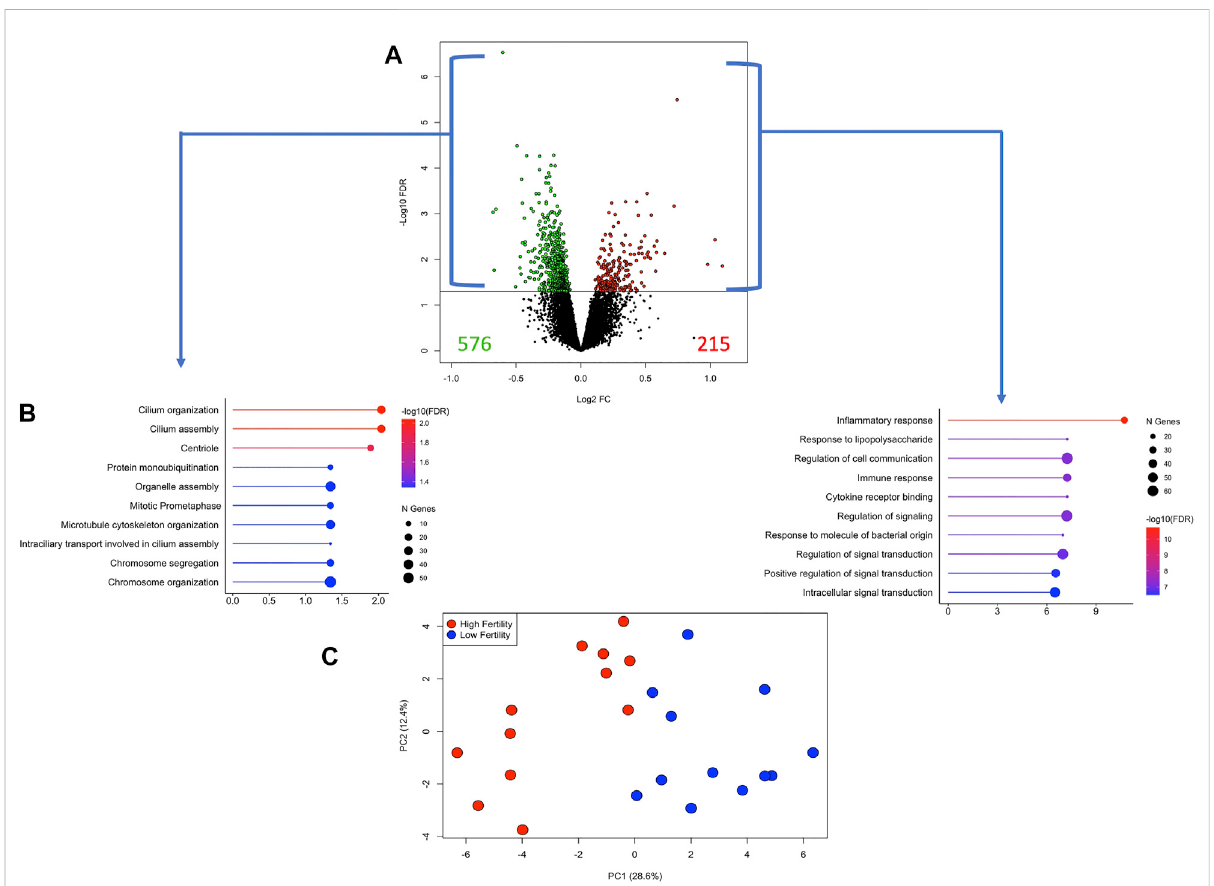
FIGURE 5 Differentially expressedgenes (DEG) in endometrial explants exposed to a Day 15 conceptus from a high fertility (HF) or low fertility (LF) bull. (A) The volcano plot shows the number of DEG more expressed in the HF or LF groups as red or green dots, respectively. The horizontal black line was drawnat p -value=0.05. (B) LollipopplotsrepresentingtheenrichmentanalysisfromDEGmoreexpressedinHF(right)orLF(left)groups.Thelength of the line (and its colour) indicates the fold change difference while the size of the dot indicates the number of genes involved. (C) Principal component analysis plot constructed with the expression of the DEG. Samples belonging to HF or LF groups are colored in red or blue,